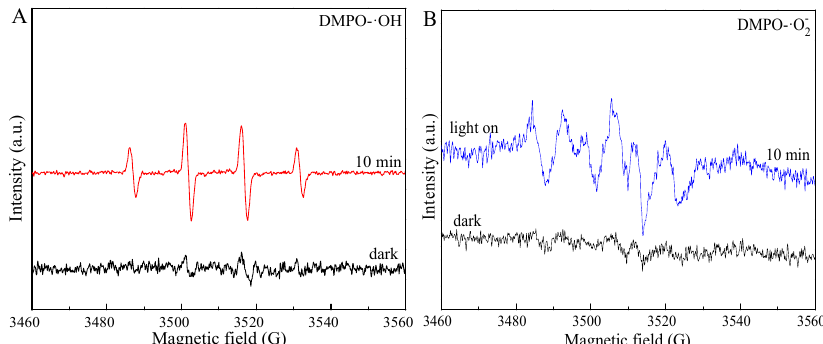
Figure 9. Electron spin resonance (ESR) spectra of ZnS@N-C-3 for 5,5-dimethyl-1-pyrroline N-oxide(DMPO)-·OH in aqueous solution( A ) and DMPO-·O 2− in methanol ( B ).